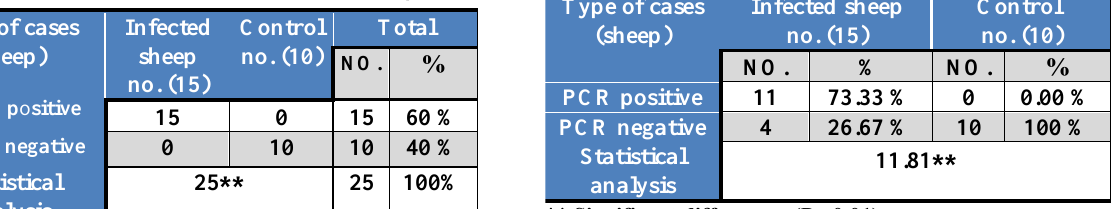
Table, 1: ELISA results for human serum samples.